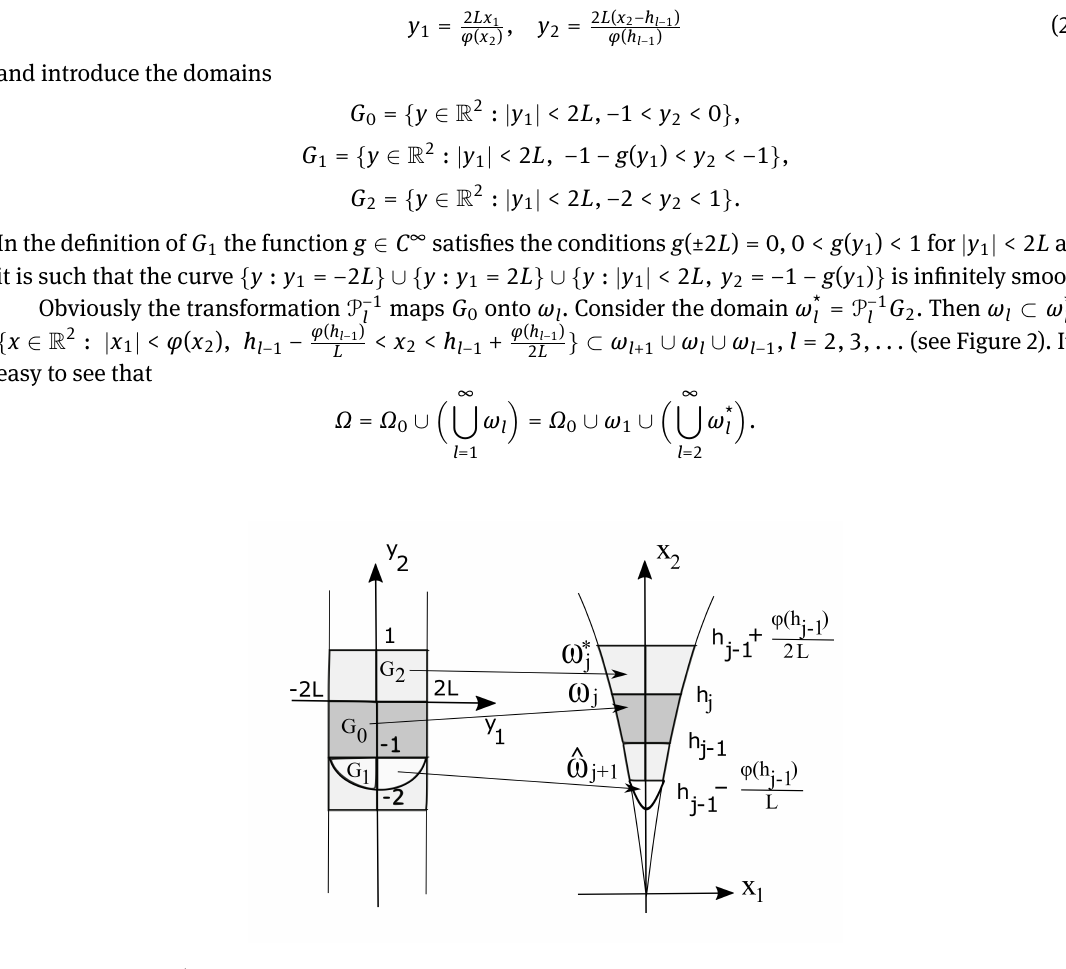
Fig. 2: Domains ω j , ω *